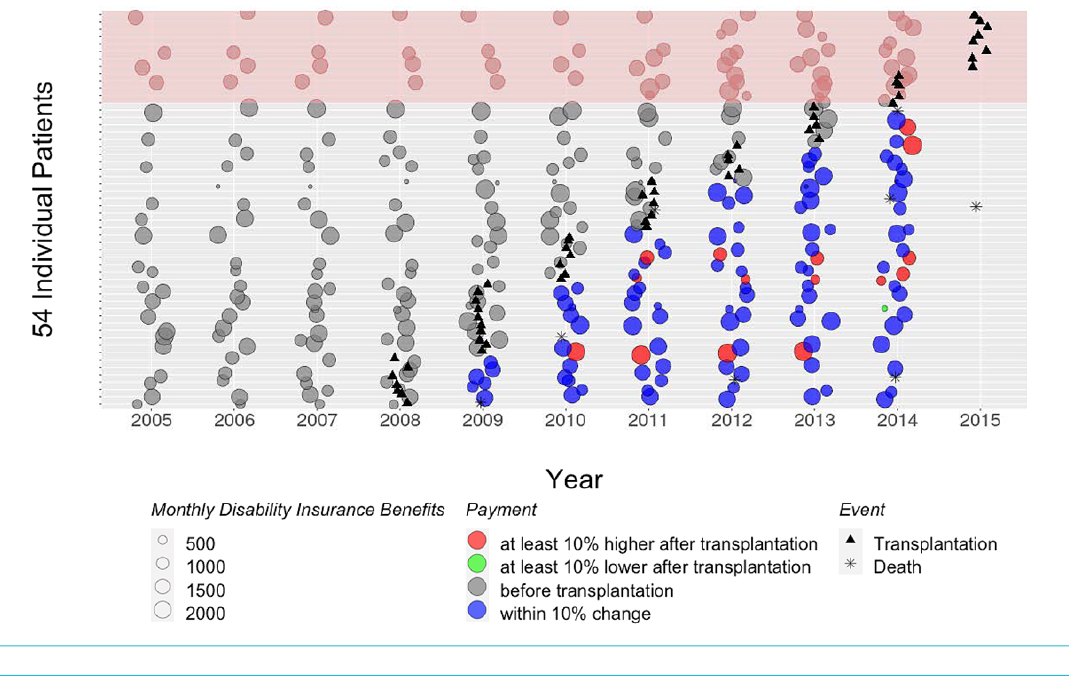
Figure 4: Self-reported health-related quality of life (EQ-5D VAS) before and 24 months after transplantation (n =